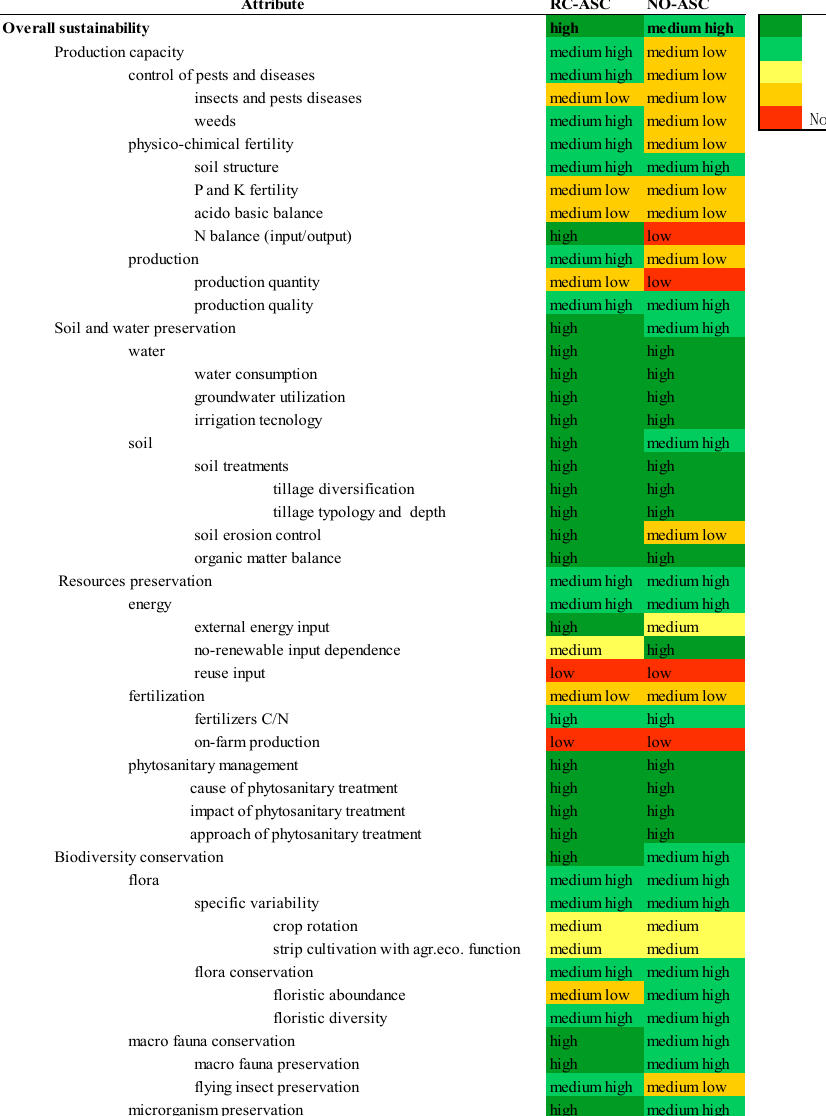
Table 1. Evaluation results of the DEXi-met model, with comparisons between the two crop managements, from the overall environmental sustainability to the basic attributes (RC-ASC = agro-ecological service crops terminated by roller crimper; NO-ASC = no agro-ecological service crops control).